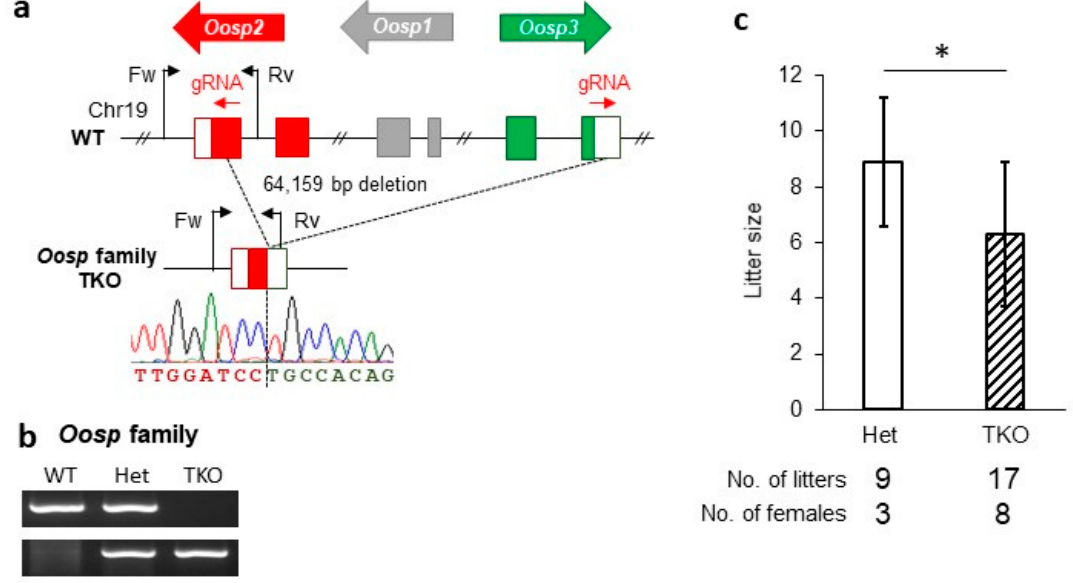
Figure 3. Generation of Oosp family KO mice and their fertility analysis. ( a ) Genomic structure and KO strategy of Oosp family ( Oosp1, Oosp2 and Oosp3 ). WT: wild-type. ( b ) Genotype verification of Oosp family KO mice by genomic PCR. WT: wild-type. ( c ) Average litter size of control and triple-KO females (* p <